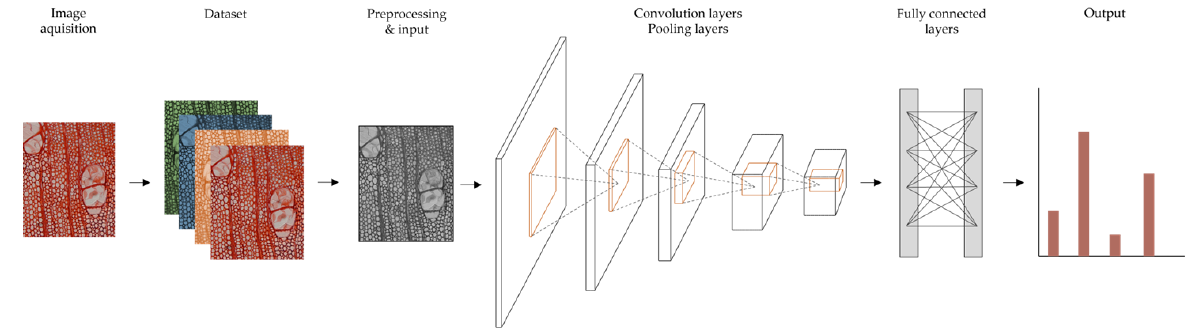
Figure 2. General pipeline of deep learning models for image classification (based on [63,68]).